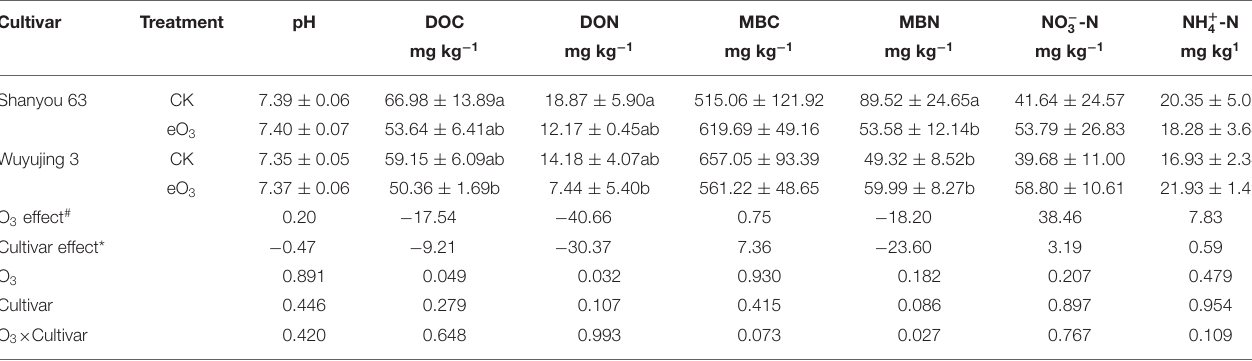
TABLE 1 | Changes in soil variables under elevated ozone conditions. Cultivar